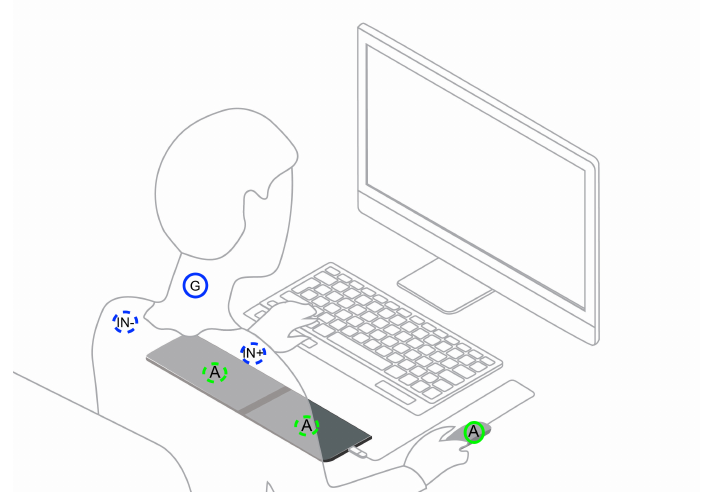
Figure 2. Experimental setup showing the electrode placement for the gold standard system (ECG REF: IN+, IN- & Ground) and the experimental electrodes location (ECG EXP: